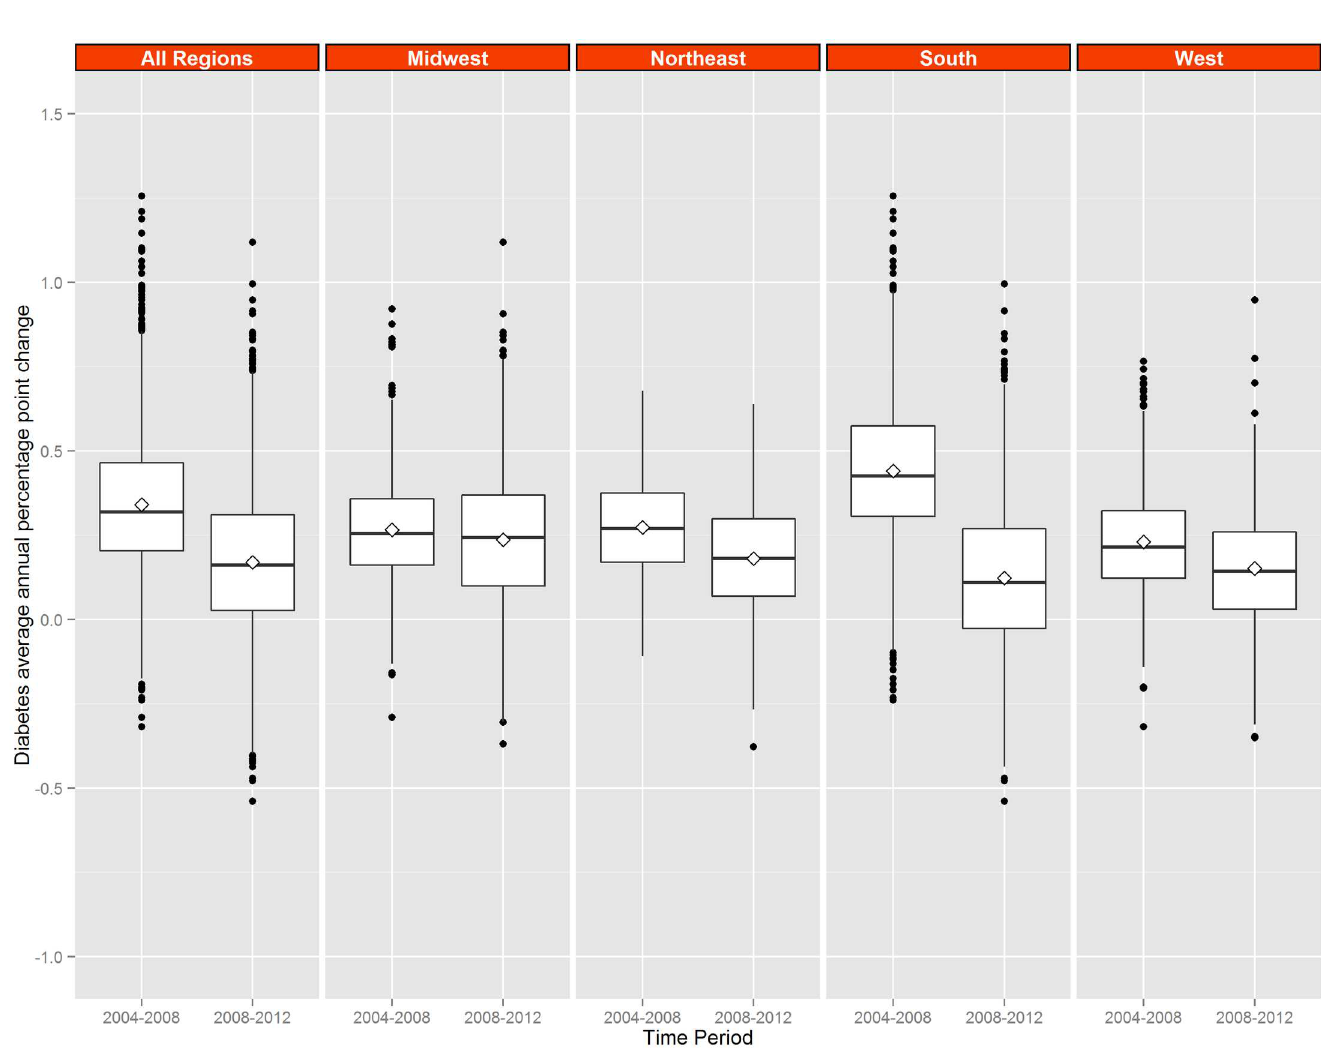
Fig 2. Distribution of county averageAnnual Percentage Point Change (APPC) in diagnosed diabetes, by Census region, 2004–2008and 2008– 2012. Northeast regionincludesConnecticut, Maine, Massachusetts, New Hampshire,New Jersey, New York, RhodeIsland, Vermont,